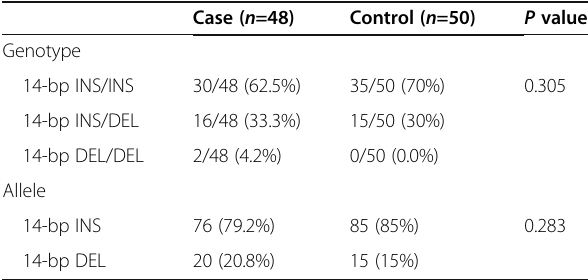
Table 3 Comparison of allelic and genotypic frequencies of 14- bp insertion/deletion polymorphism of HLA-G gene between MS patients and control groups